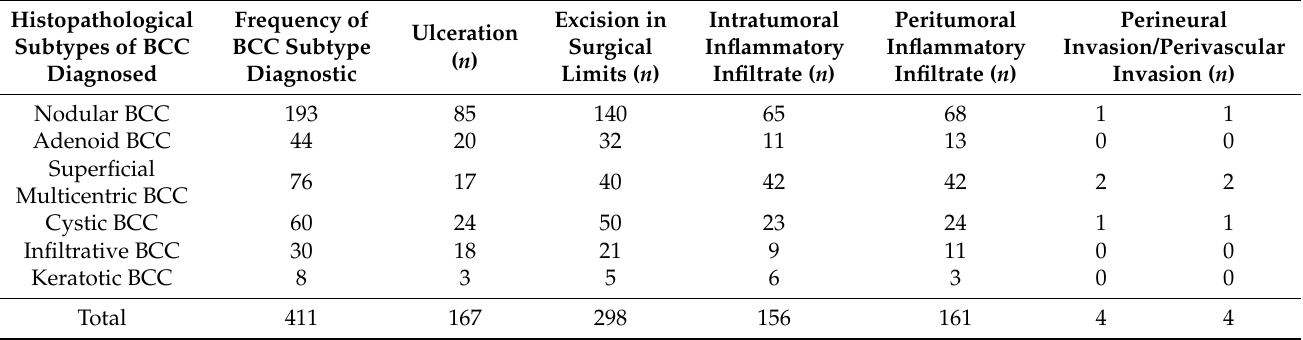
Table 4. Presence of histological and histopathological parameters of the tumor formations analyzed in each of the six subtypes of basal cell carcinoma that were